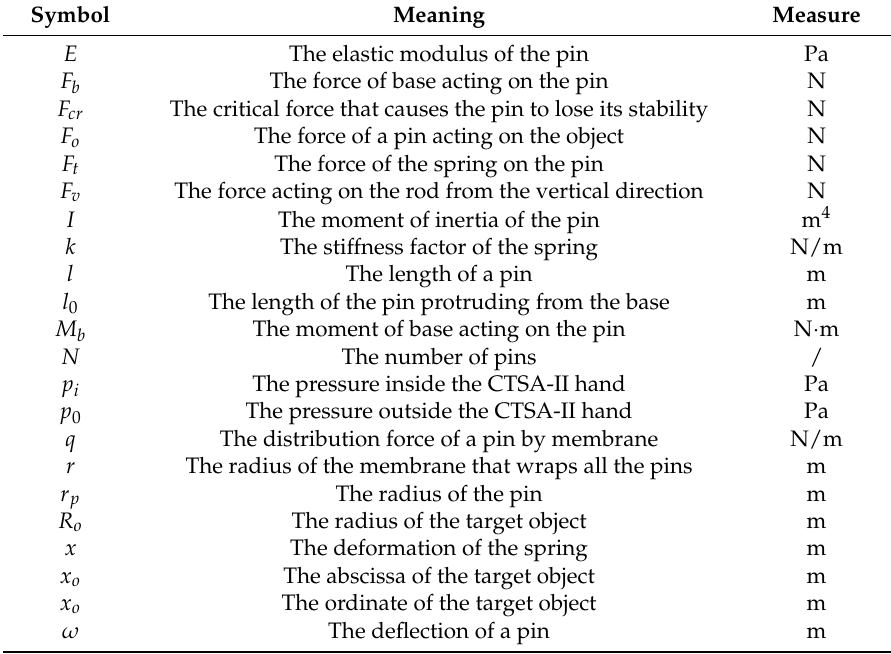
Table 1. The parameters used in the model of CTSA-II